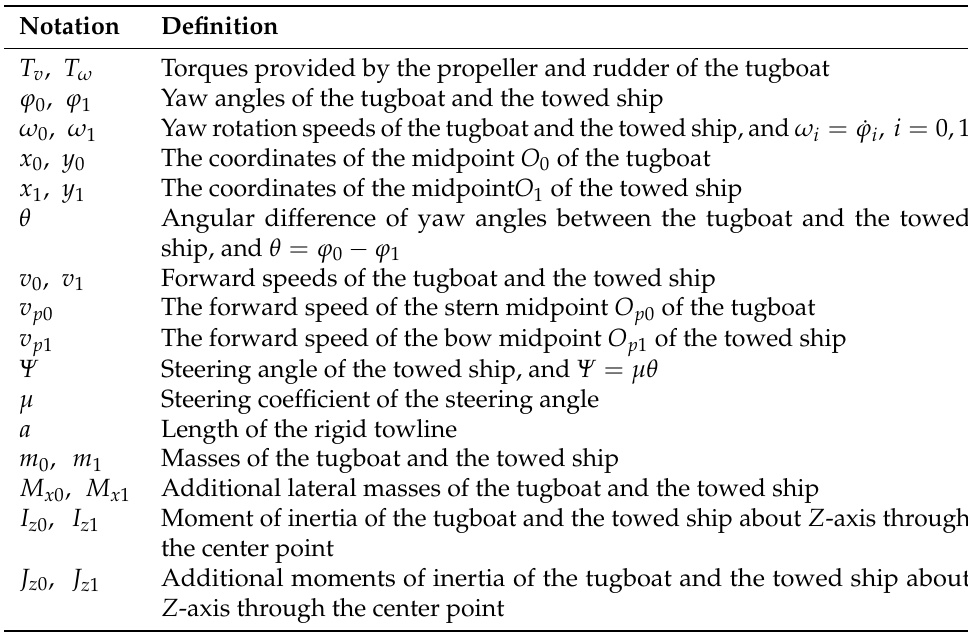
Table 1. Parameters and variables of the ship towing